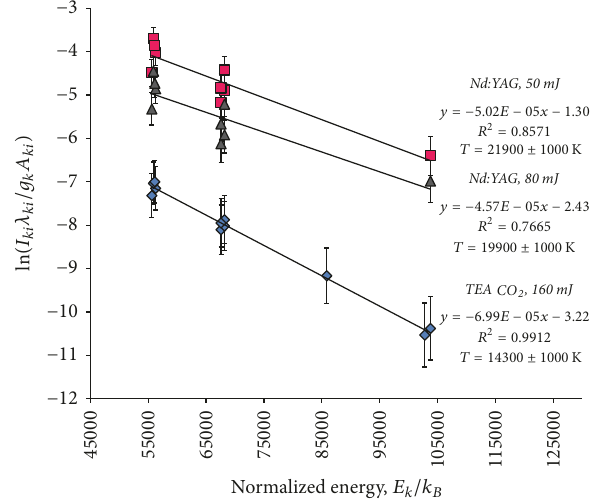
Figure 4: Boltzmann’s plot for laser-induced plasma of basalt at atmospheric pressure utilizing Fe II transition lines listed in Table 1. 𝑇 exc = −1/ Slope. The error bars account for combined uncertainties of line intensity measurements and of transition probability accuracy (Table